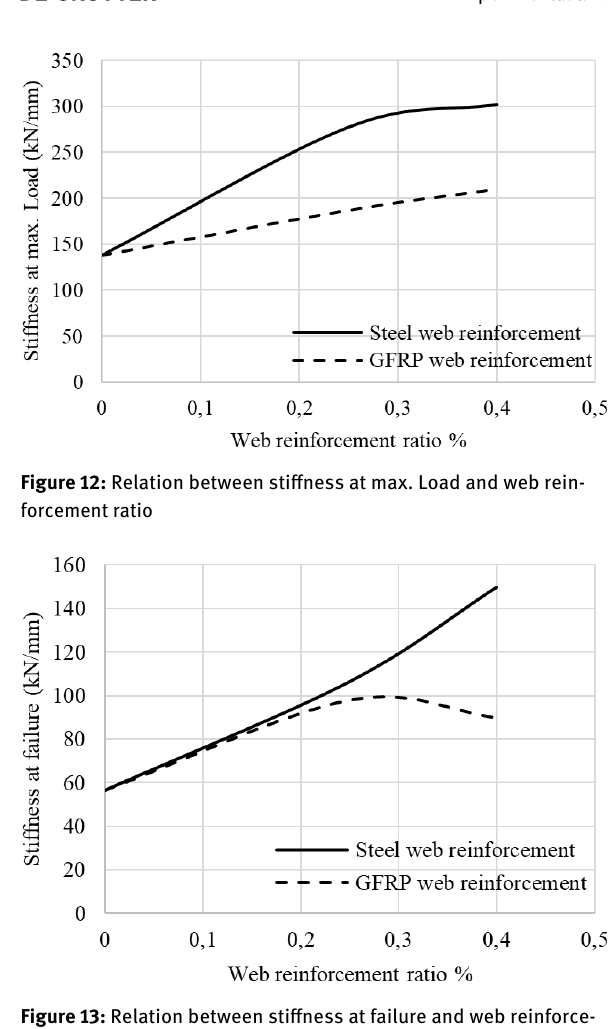
inforced by GFRP from 6 to 60% compared with a deep beam without web reinforcement. The stiffness at failure increased from 88 to 164% for the deep beam with steel web reinforcement and from 2.65 to 73% for deep beam reinforced with GFRP as web reinforcement, except BG2, no enhancement occurred in stiffness at failure, compared with deep beam without web reinforcement.